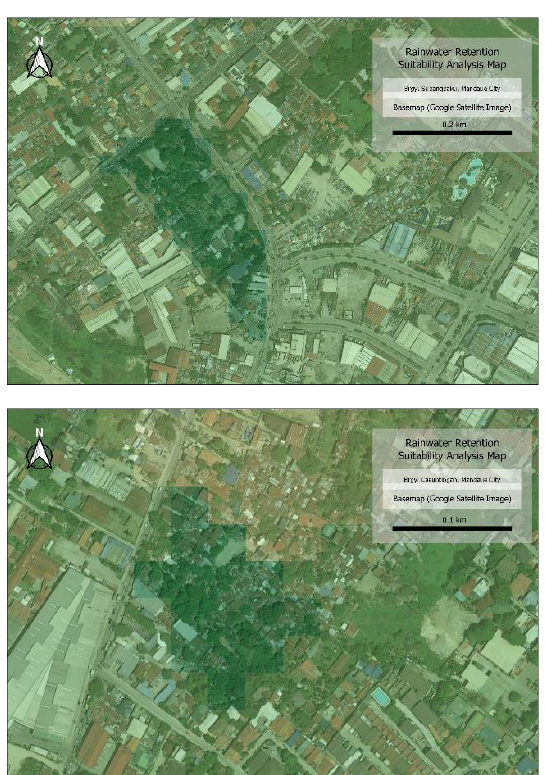
Figure 11. Sample suitable